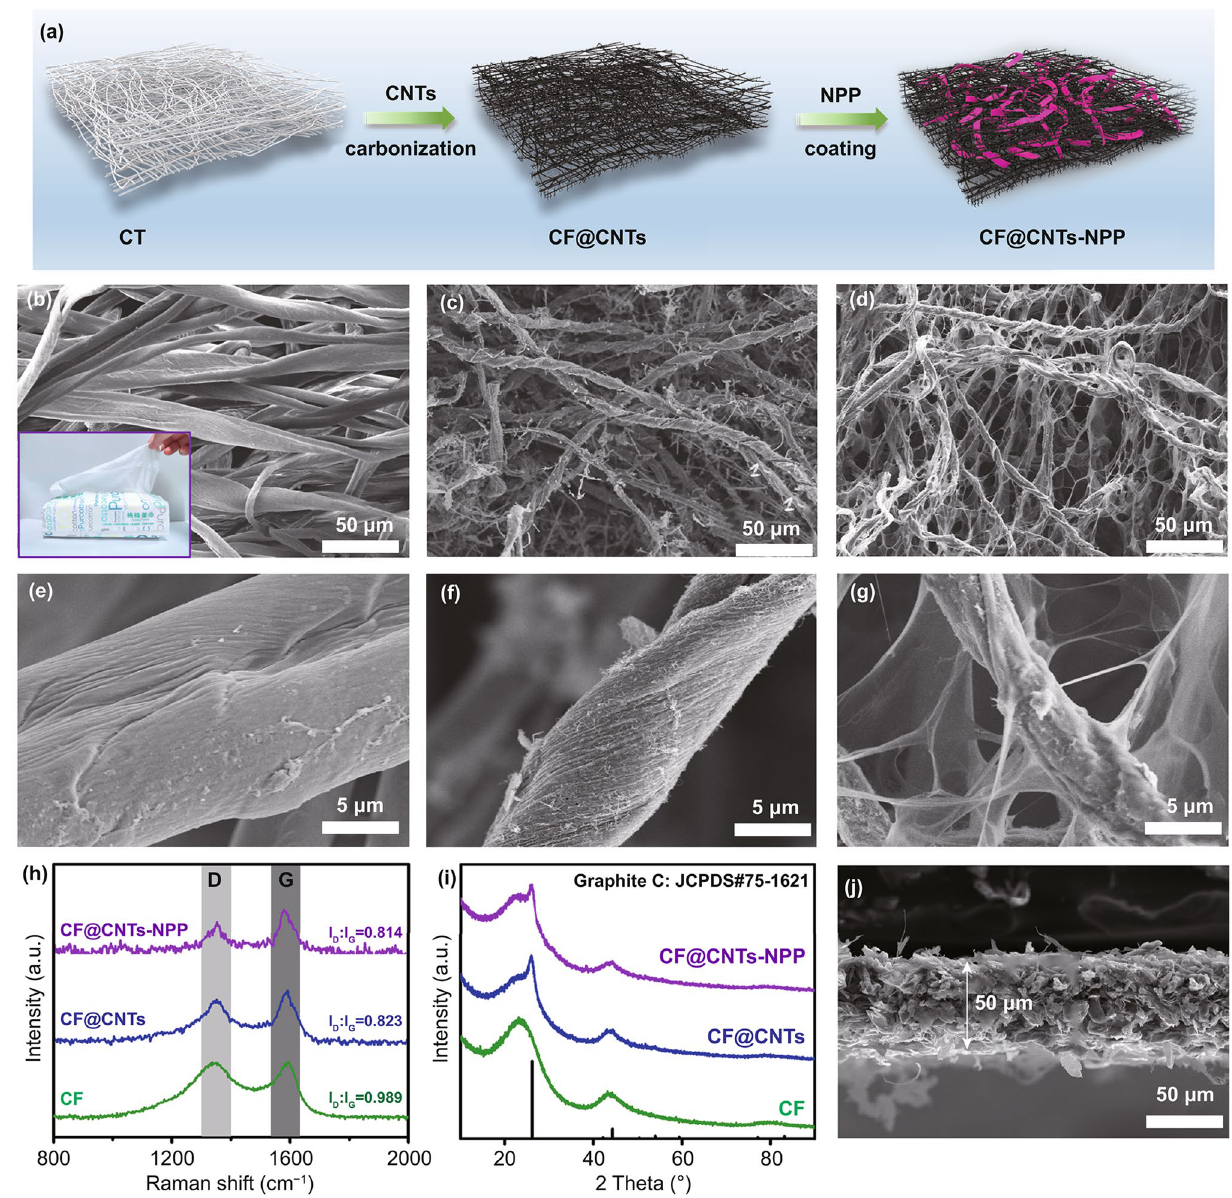
Fig. 2 a Schematic diagram of the fabrication process of the CF@CNTs-NPP composite. Top-view FESEM images of b , e CF, c , f CF@CNTs, and d , g CF@CNTs-NPP composite. h Raman spectra and i XRD patterns of CF, CF@CNTs, and CF@CNTs-NPP. j Cross-sectional FESEM image of the CF@CNTs-NPP